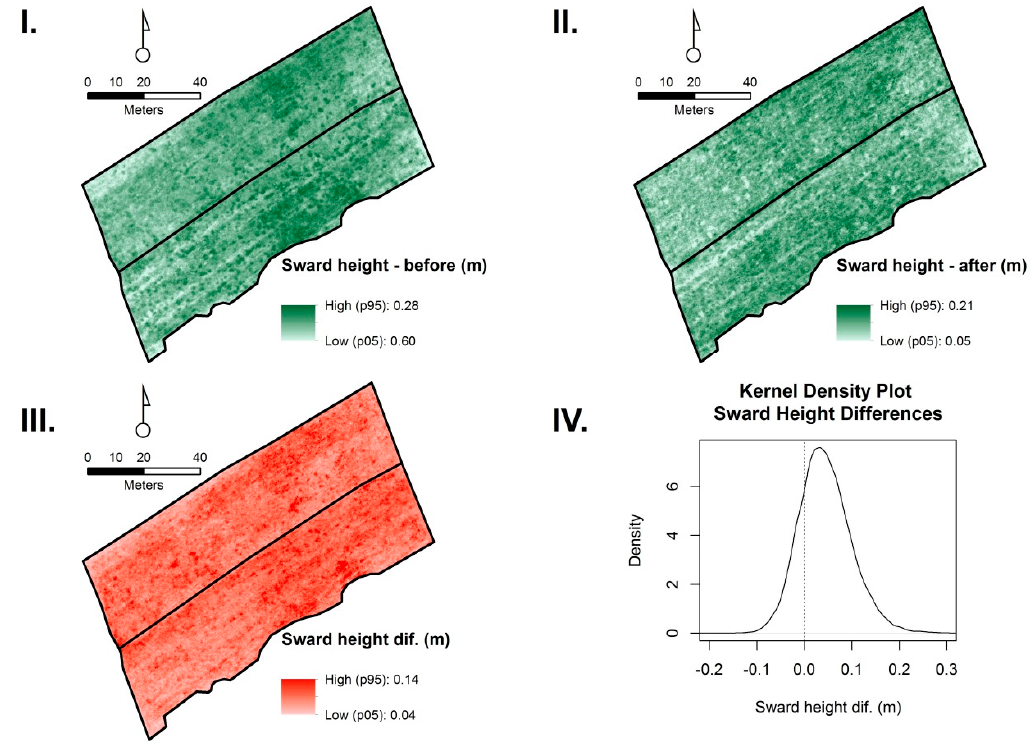
Figure 5. Sward height before ( I ) and after ( II ) cattle grazing, sward height differences ( III ) (sward height ‘before’ minus sward height ‘after’) and associated Kernel density plot ( IV ). The majority of the pixel values were associated with positive values (intakes or trampling by cattle).